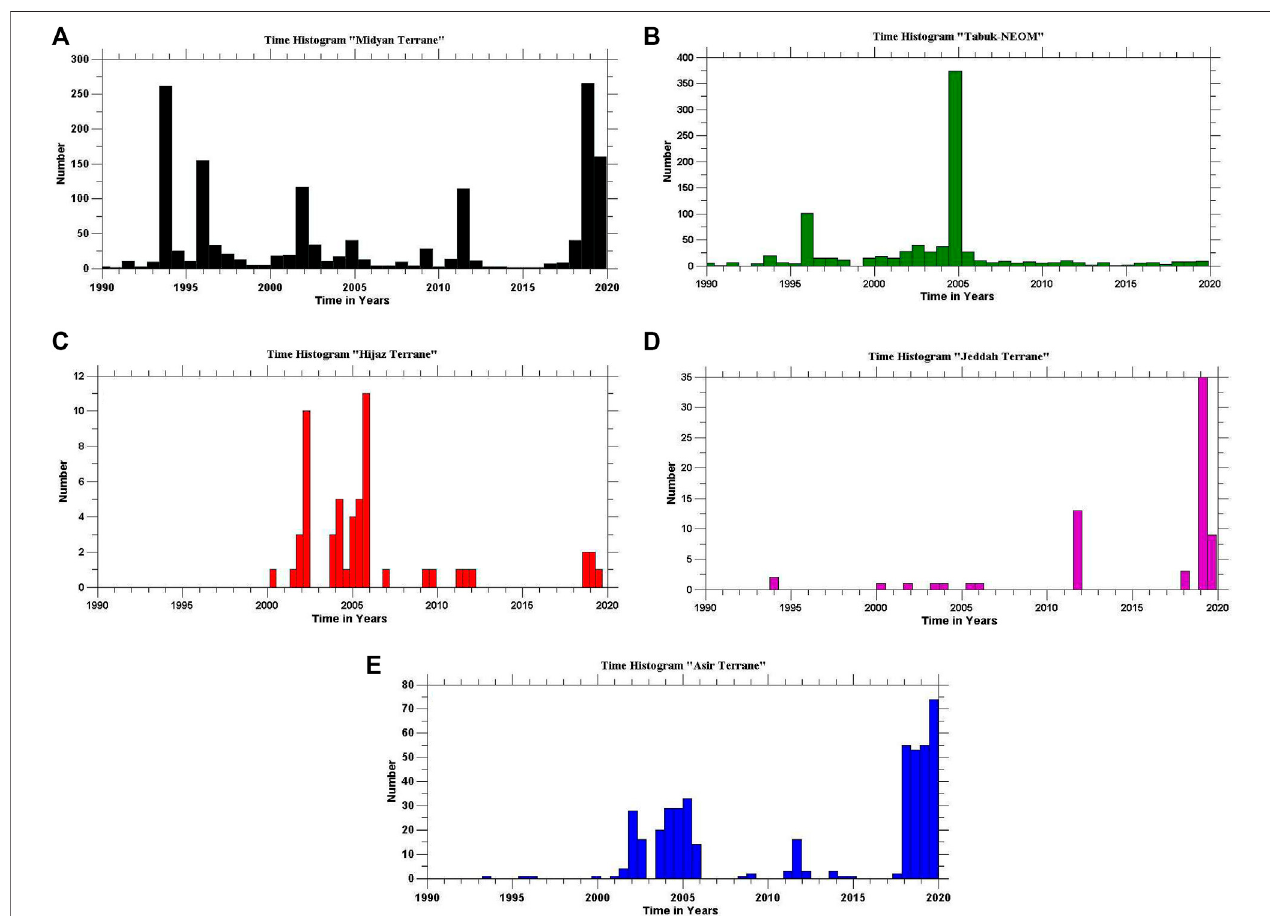
FIGURE 11 | (A – E) Time histograms for the studied regions as represented by the color legend.